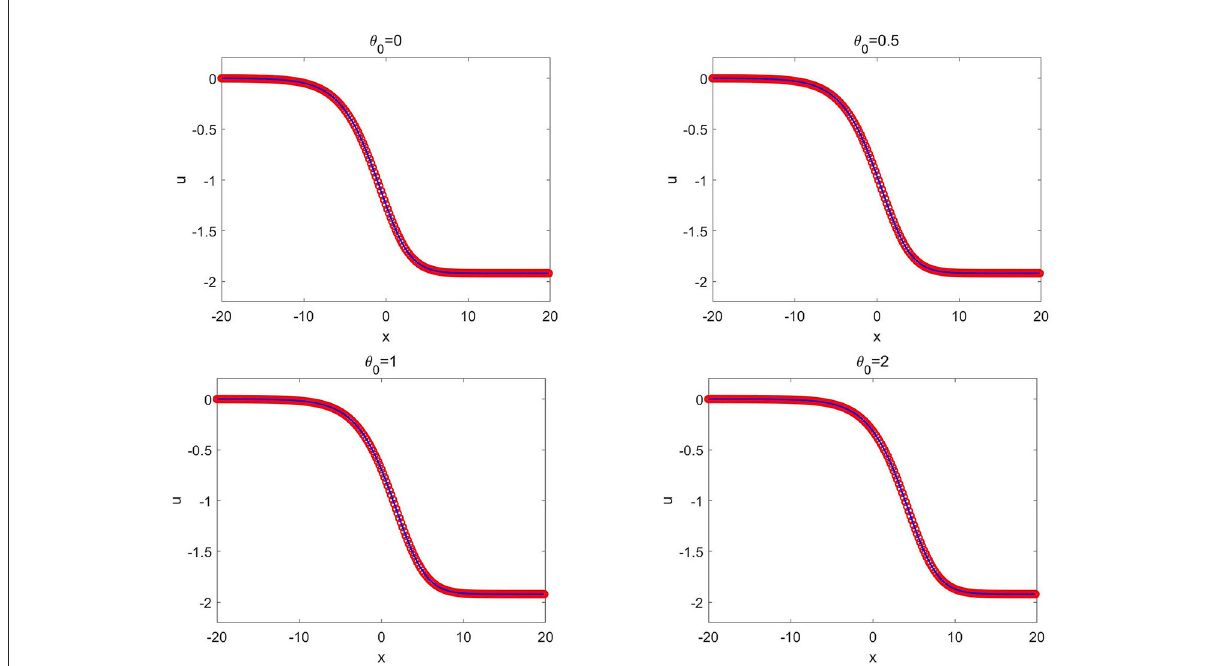
FIGURE5 KdV-Burgers equation of Example 3.4: the CANN solution (red circles) and the exact solution (solid blue lines) at T